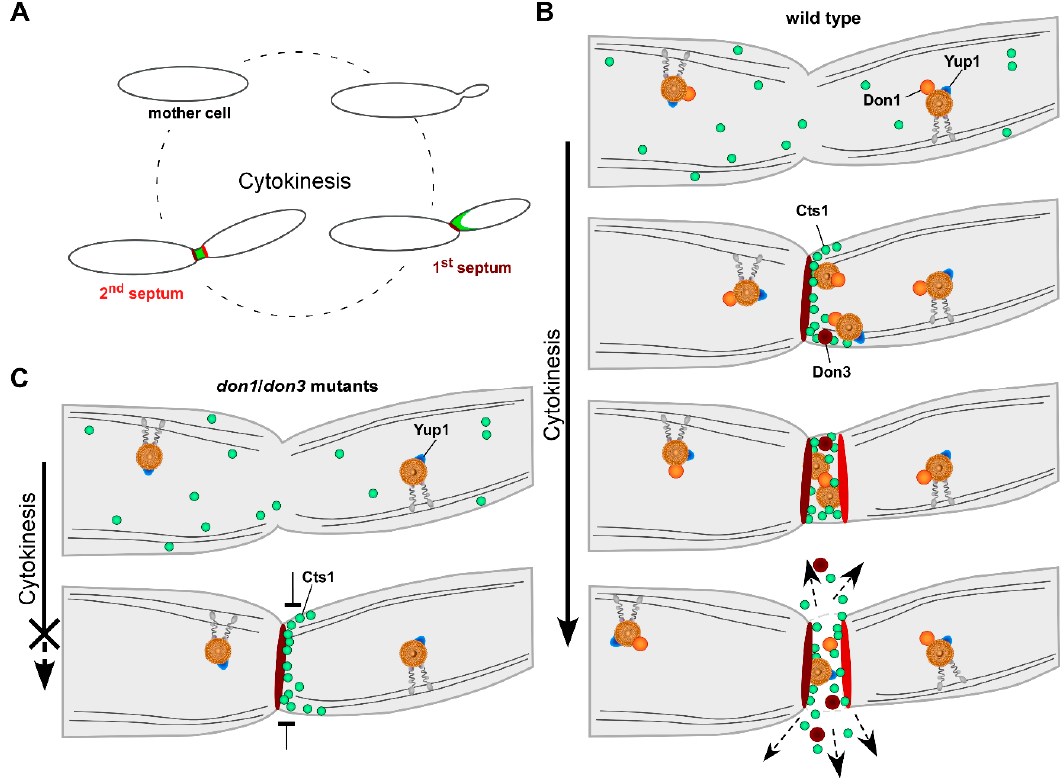
Figure 2. Current model of unconventional secretion via the fragmentation zone in U. maydis . ( A ) Cts1 (represented in green) localization is dependent on the cell cycle stage. During early cytokinesis, it is transferred to the daughter-cell side of the primary septum (dark red). As soon as the secondary septum (red) is formed, it is entrapped in the fragmentation zone from where it is released. The progress of cytokinesis is indicated by the dotted circle (clockwise). ( B ) Model of wild typic unconventional Cts1 (green circles) secretion mediated by the fragmentation zone. Primary (dark red) and secondary (red) septa are formed sequentially during cytokinesis. Early endosomes (brown vesicles) positive for the markers Yup1 (blue) move along microtubule tracks (dark grey lines) throughout the fungal cells using motor proteins (grey). Don1 (orange circles) is attached to the endosomes via a FYVE domain. During cytokinesis, Yup1-positive endosomes accumulate at the daughter-cell side of the primary septum. In addition, Don3 (dark red circles) and Cts1 are translocated to this subcellular site. Black arrows indicate the site of unconventional secretion. ( C ) Don1 and Don3 are essential for secondary septum formation and cells lacking either protein are not able to separate. Although Cts1 is still recruited to the daughter-cell side of the primary septum, it cannot be detected extracellularly, suggesting that unconventional secretion requires a functional fragmentation zone. Impeded secretion is indicated by the flat arrows. Models were adapted from Göhre et al. [57] .